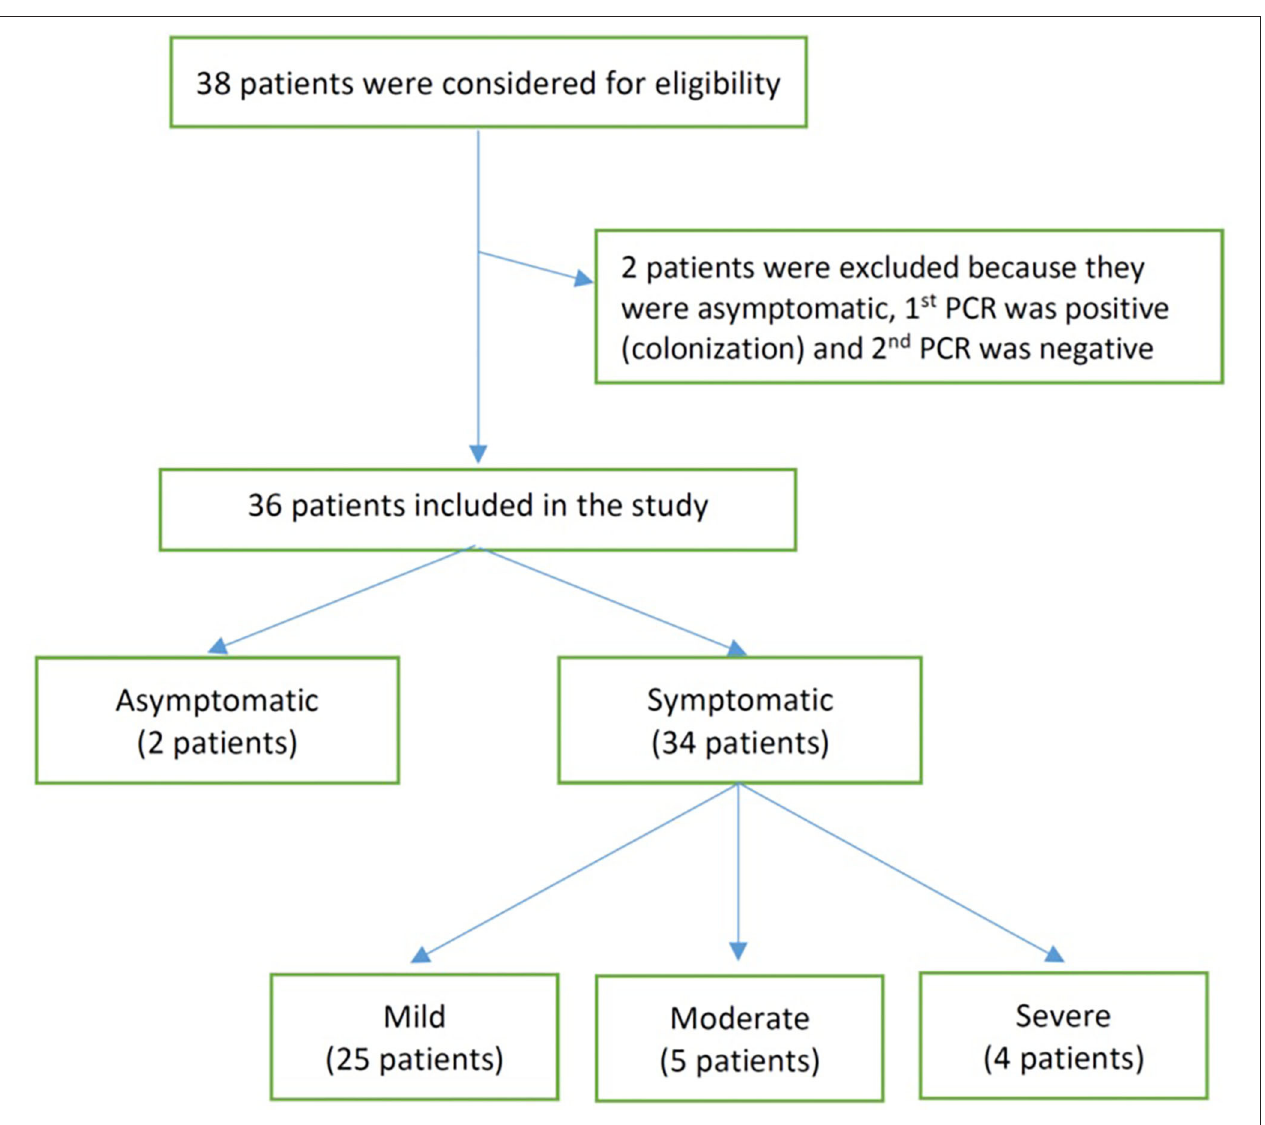
FIGURE 1 | Flow chart shows the numbers of individuals at each stage of